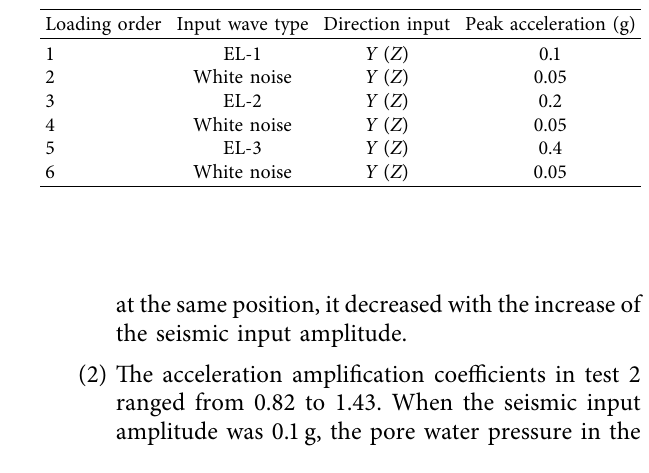
Shaking direction Y Figure 6: Vibration direction of shaking table. Table 4: Test